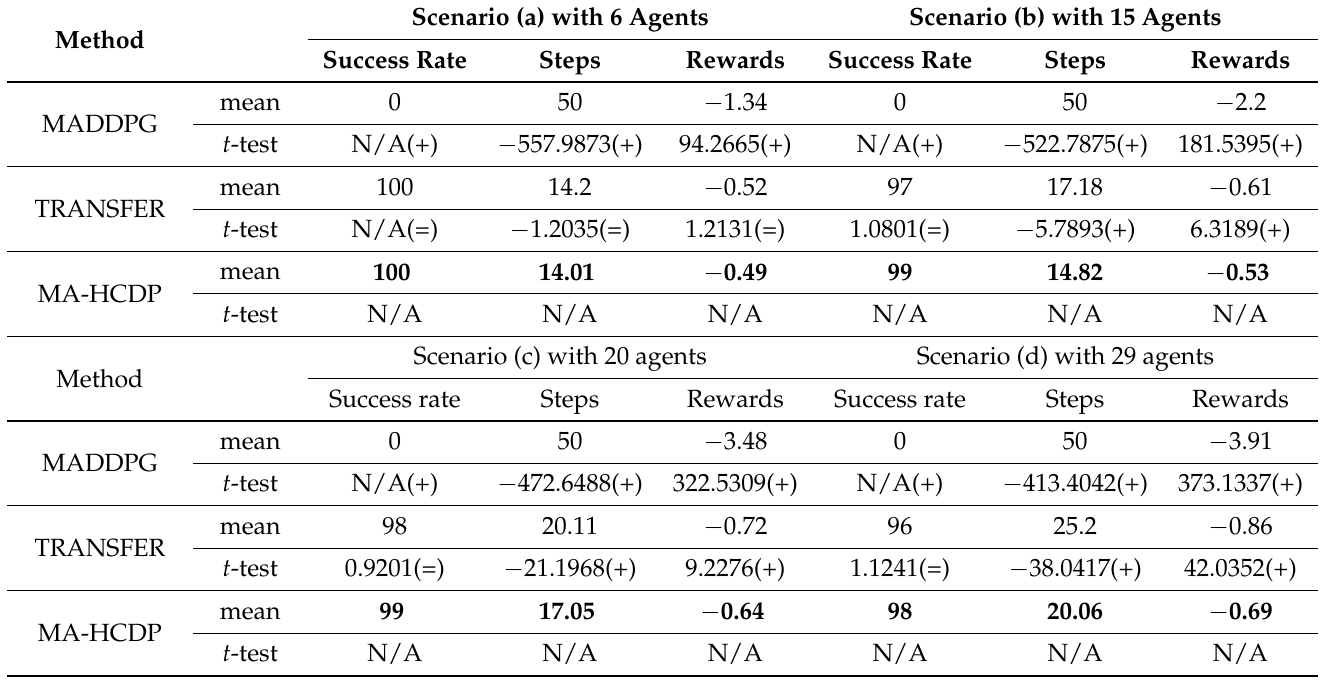
Table 2. Evaluation results of cooperative